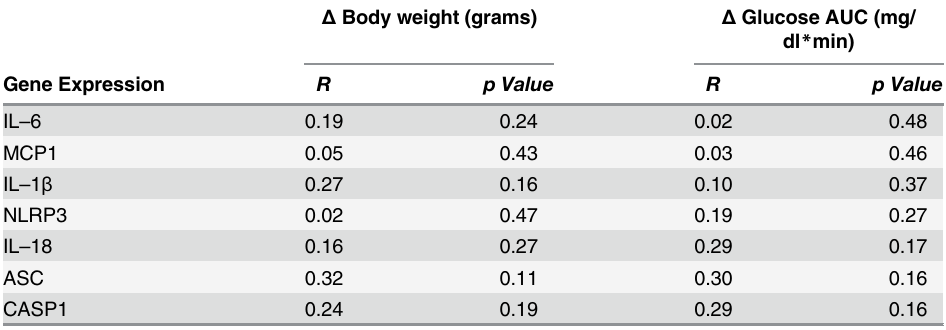
Table 4. Correlation analysis between gene expression, and changes in body weight (left) and abso- lute change in insulin resistance (right) in subcutaneous adipose tissue. Δ Body weight